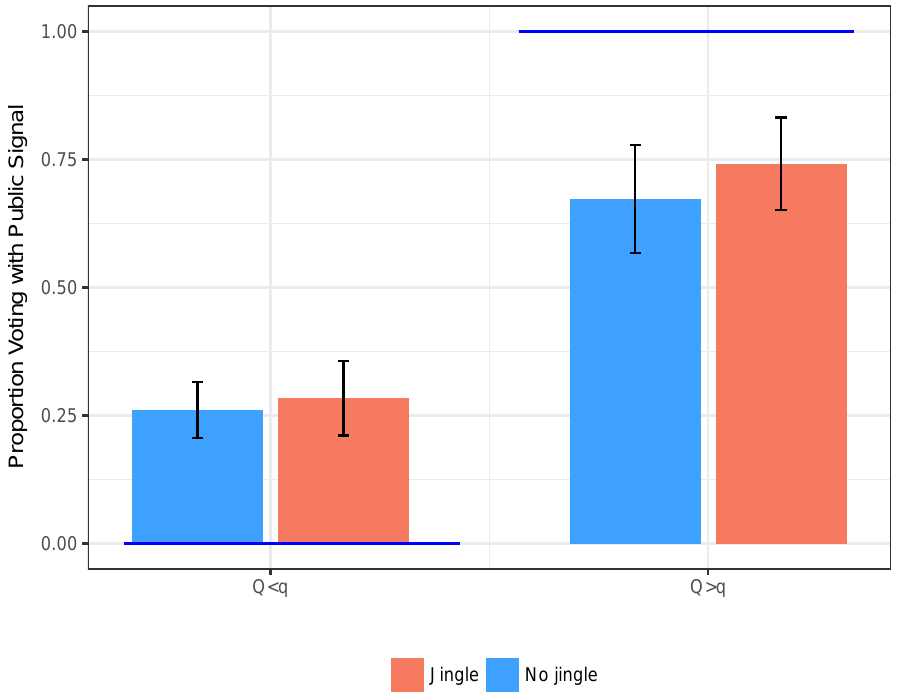
Figure A3. Jingle effects in individual sessions. Average fraction of votes with public signal under mismatch and 95% confidence intervals. Standard errors are clustered at the individual level. Blue lines represent the unique optimal decision in the individual treatment (follow the more precise